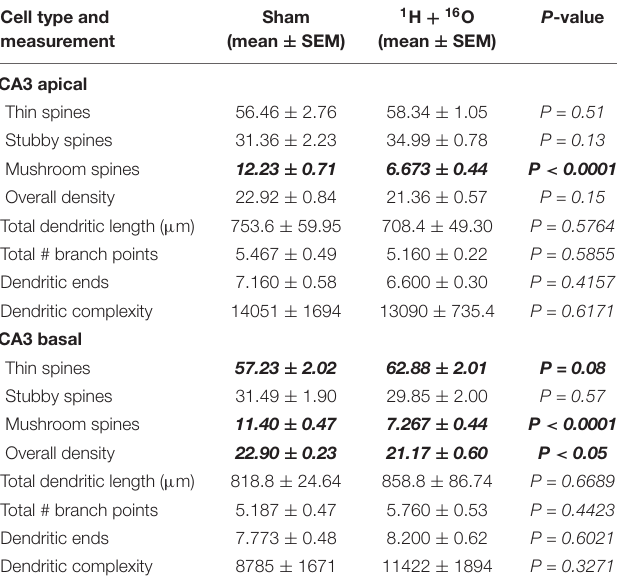
TABLE 3 | Effects of 1 H + 16 O irradiation on dendrite morphology in the CA3. Cell type and measurement